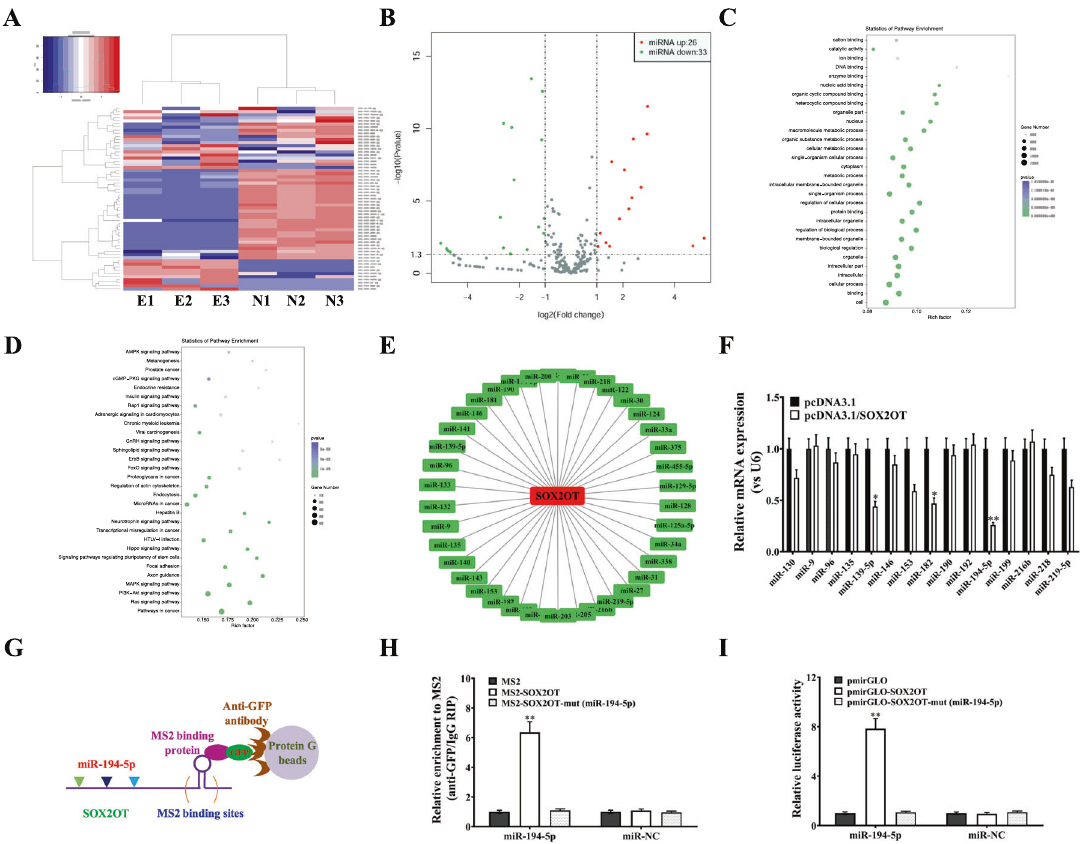
Fig. 4 LncRNA-SOX2OT functions as a ceRNA regulating miR-194-5p in osteoclasts. A Cluster analyses of the differentially expressed miRNAs in the plasma of three NSCLC patients without metastasis (N1, N2, and N3) and three NSCLC patients with BoM (E1, E2, and E3). Red represents high gene expression, and blue represents low gene expression. The colour brightness of each band re fl ects the difference in multiples (log 2(AR/N)). B Volcano graph of miRNA differential expression analysis among samples (N1, N2, and N3; E1, E2, and E3). The abscissa represents the miRNA expression fold change in different samples, and the ordinate represents statistical signi fi cance of the miRNA expression difference. The red dots indicate the signi fi cant upregulation of miRNA expression, and the green dots indicate the signi fi cant downregulation of miRNA expression. C , D Kyoto Encyclopaedia of Genes and Genomes (KEGG) analysis was performed to identify the differentially expressed miRNAs involved in biological pathways. E An interaction network diagram was constructed between lncRNA-SOX2OT and the differentially expressed miRNAs using online programs including microRNA.org, star-Base v2.0 and MirTarget2. F Real-time PCR assay validated the RNA sequencing and target prediction results. U6 was used as the internal control. G , H MS2-RIP assay and real-time PCR assay detected the endogenous association of miR-194-5p with lncRNA-SOX2OT. U6 was used as the internal control. I Luciferase activities were analysed in RAW264.7 cells co-transfected with miR-194-5p and luciferase reporters containing the empty vector, lncRNA-SOX2OT wild-type transcript or lncRNA-SOX2OT mutant transcript. The fi nal data are presented as the relative ratio ( fi re fl y luciferase activities/Renilla luciferase activities). Data are representative of three biological replicates, and each experiment was performed at least three times independently. *, P < 0.05; **, P < 0.01 (t